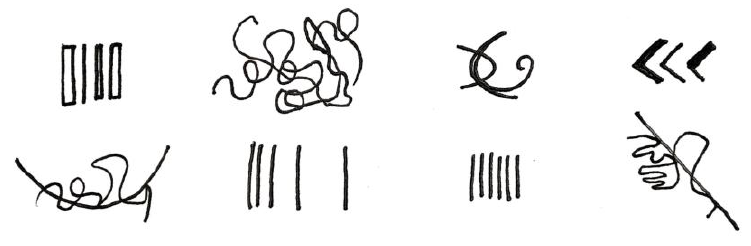
Figure 3. Repeated pattern of lines.